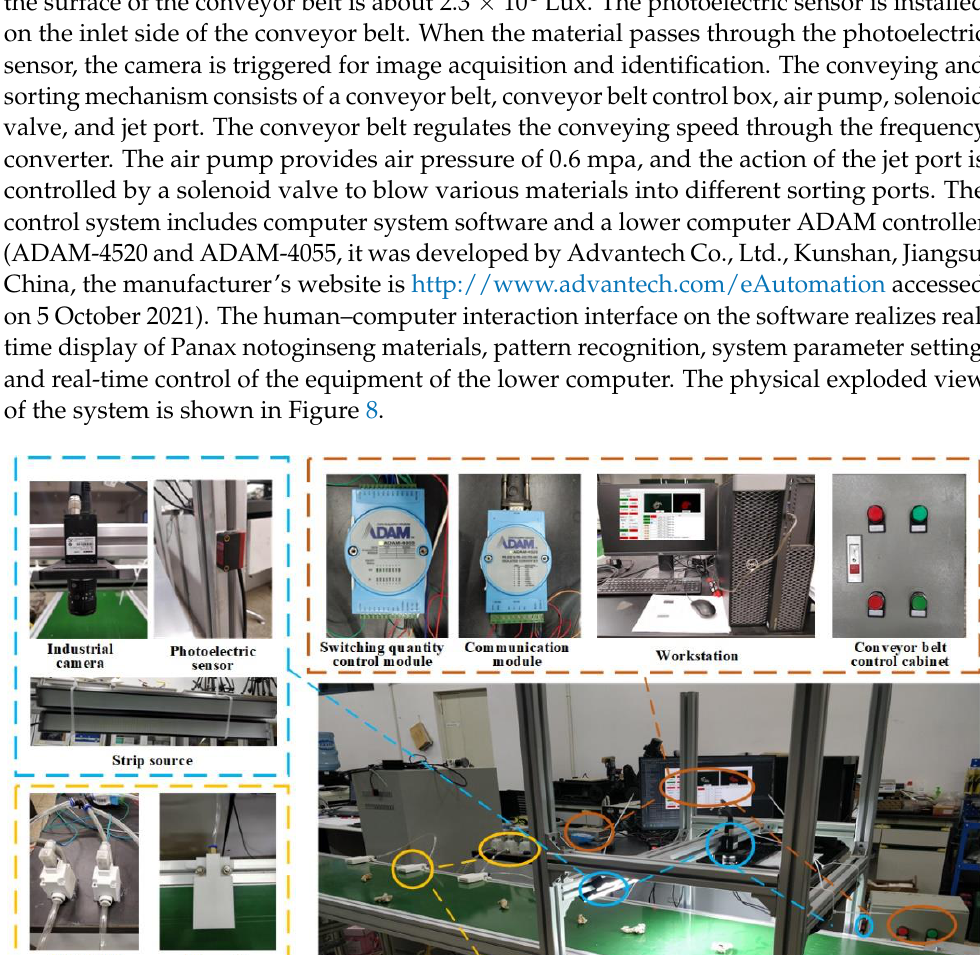
10 of 18 Figure 7. Visualization of segmentation effects of different models. 4. Design and Experiment of the Sorting Robot System